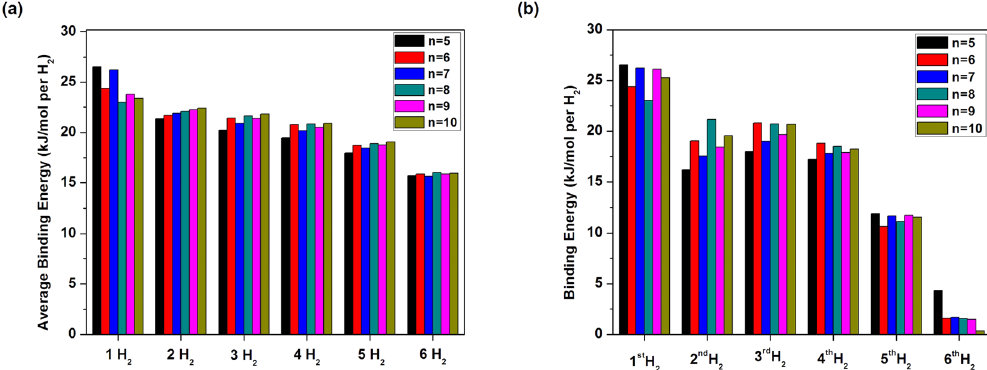
Figure 7. ( a ) Average H 2 binding energy on Li 2 C n ( n = 5–10) as a function of the number of H 2 molecules adsorbed on each Li atom, and ( b ) the binding energy of the y th H 2 molecule ( y = 1–6) on Li 2 C n ( n = 5–10), calculated using TAO-BLYP-D.